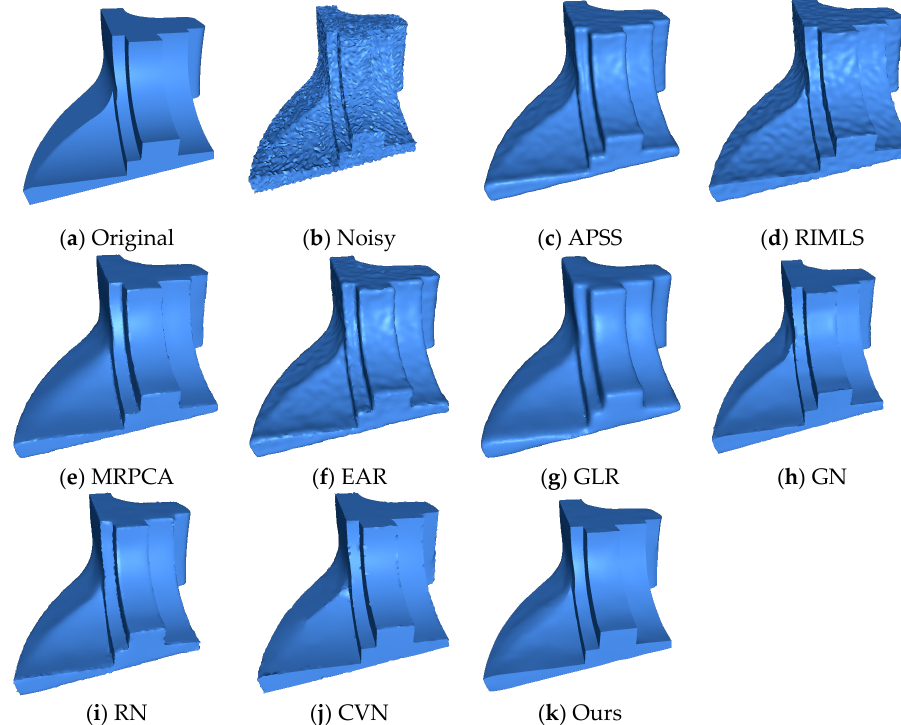
Figure 5. The Fandisk model with non-uniform distribution of points, corrupted by Gaussian noise ( σ = 0.28 h). We can see that the proposed method was able to preserve sharp features effectively when compared to the state-of-the-art methods.